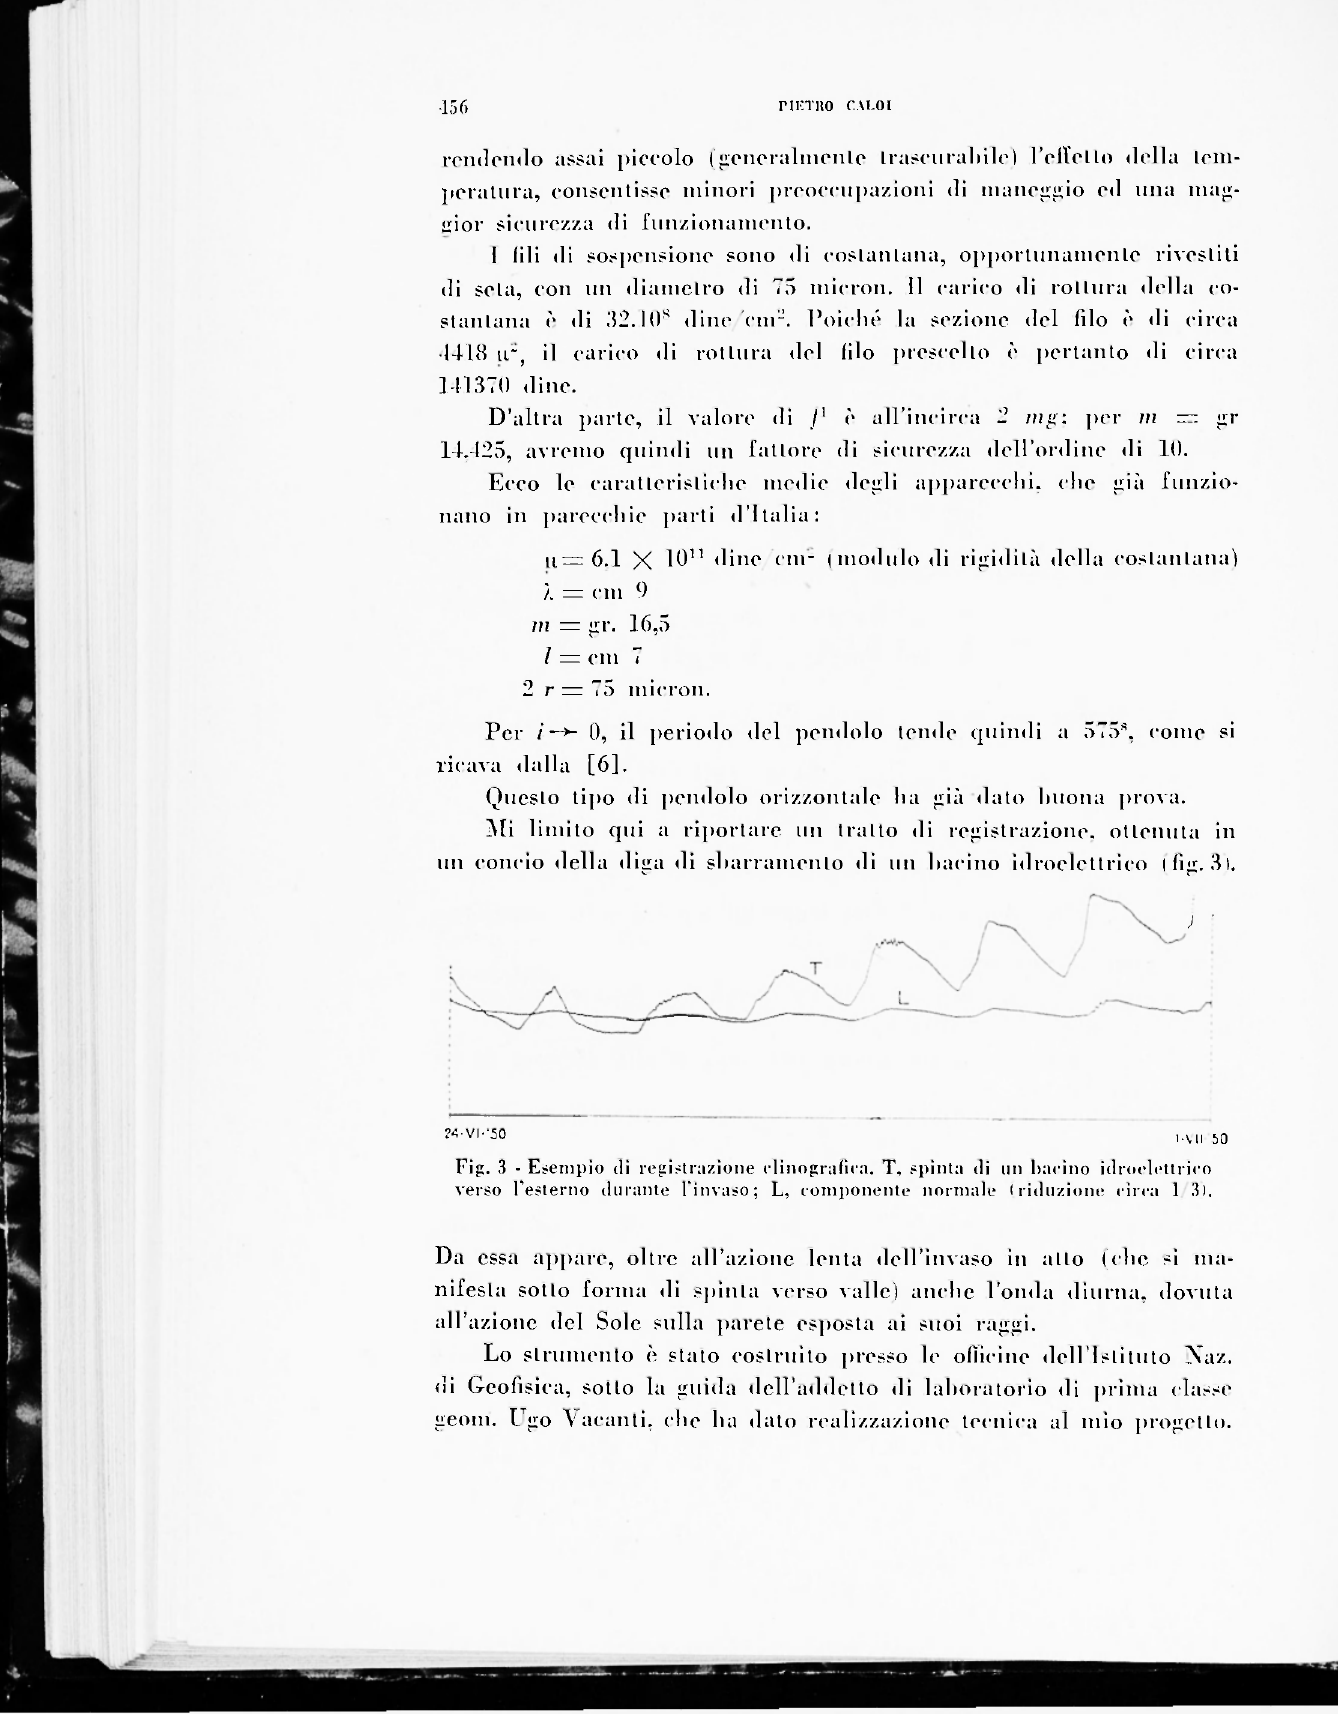
Fig. 3 - Esempio di registrazione clinografica. T, spinta di un bacino idroelettrico verso l'esterno durante l'invaso; L, componente normale (riduzione circa 1 31.